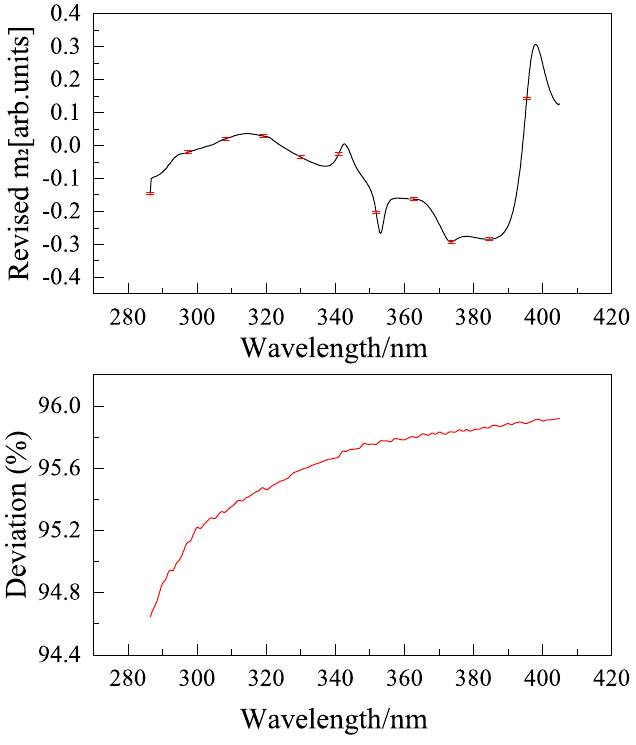
Figure 17. Comparison of Mueller matrix element m 2 for channel 1 before and after correction for UV hyperspectral